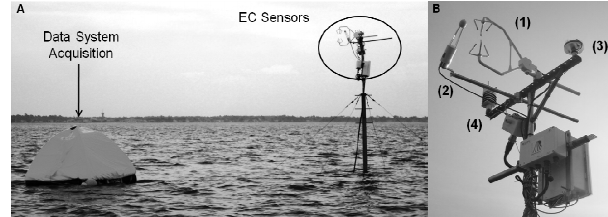
Fig. 2. The Eddy Covariance system deployed in the Arcachon flat in April 2009. (A) General view of the system measurement show- ing the sensors mounted on the mast and the data system acquisi- tion Campbell CR3000 in the lifeboat; (B) the sensors: (1) the sonic anemometer CSAT3 , (2) the infra-red gas analyser LI-7500, (3) the quantum sensor SKP215 and (4) the meteorological station ( Vaisala WXT510 ). The measurement heights were 4.20, 5.50, 7.0 and 5.0m in September–October 2007, July 2008, September–October 2008 and April 2009,